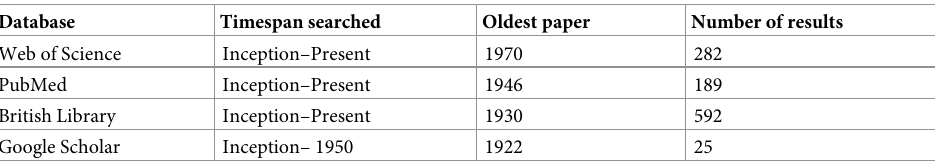
Table 1. Summary of databases, search limits and paper